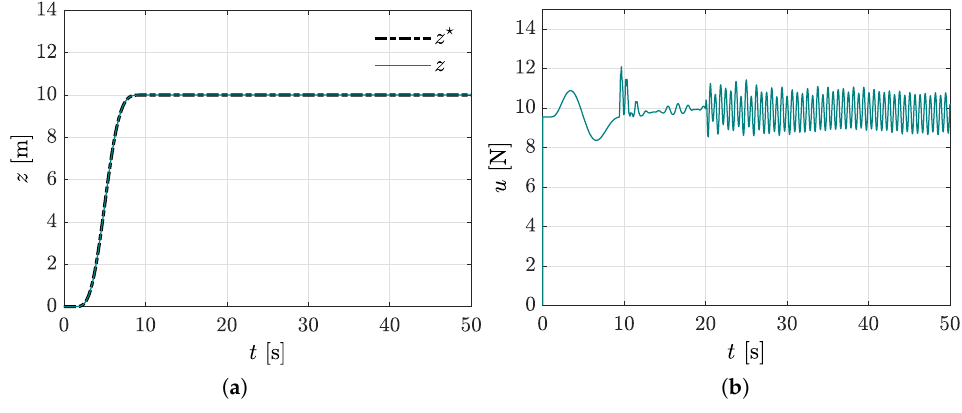
Figure 15. Controlled vertical dynamics. ( a ) Tracking using the vibration absorber with disturbances.